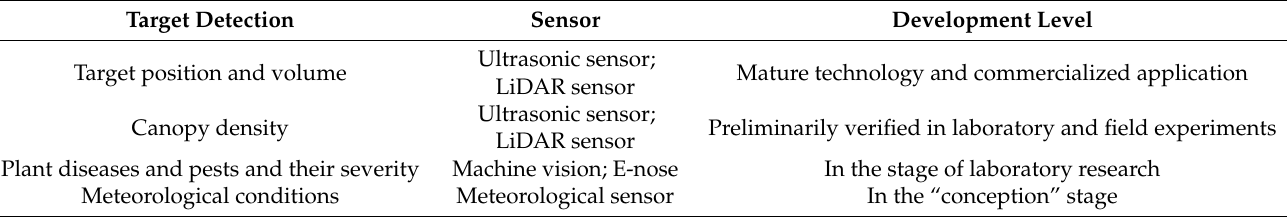
Table 2. Target information detection methods and their corresponding development levels in variable-rate sprayers.